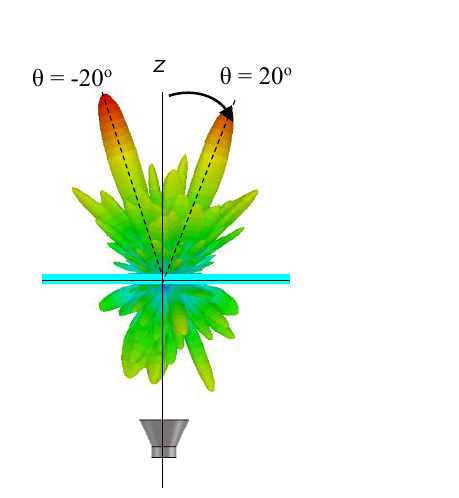
Figure 14: The 3D power pattern of dual beam transmitarray in the same structure.